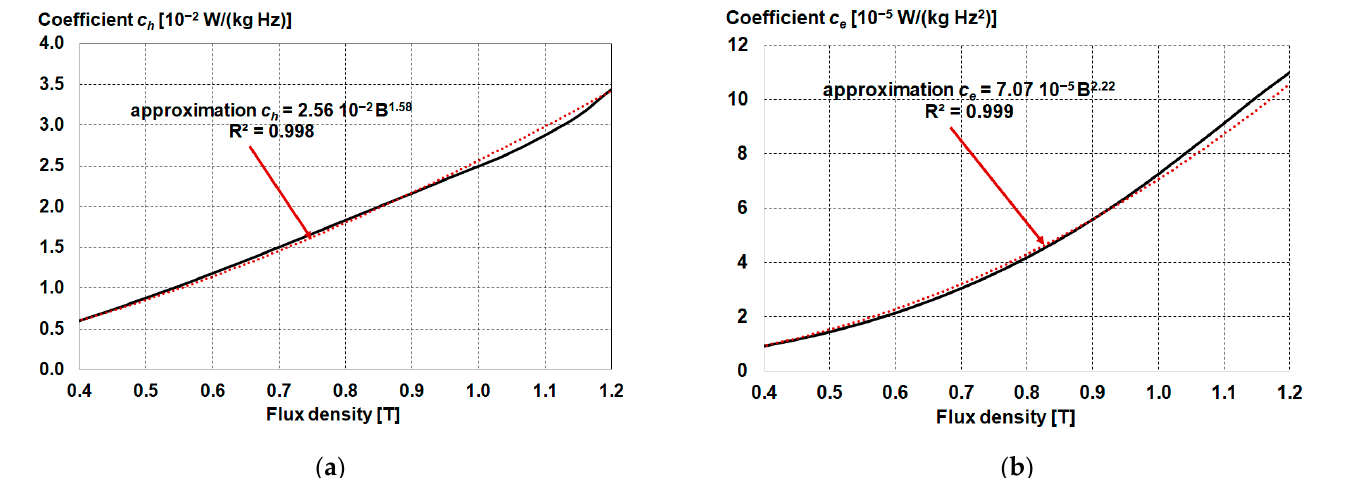
Figure 5. Approximations of the coefficient ( a ) c h ; ( b ) c e . calculated for the range of 200–500 Hz for samples with a width of 10 mm cut with a guillotine for the induction range from 0 to 0.4 T (red dotted line – approximation).